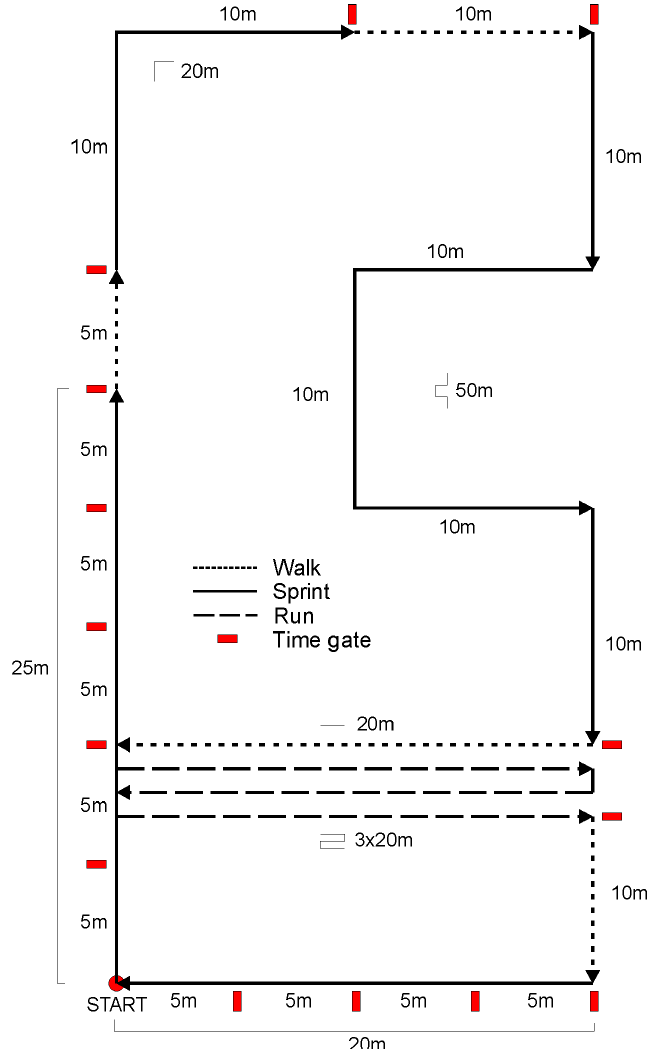
Figure 1. Circuit sport-specific running.